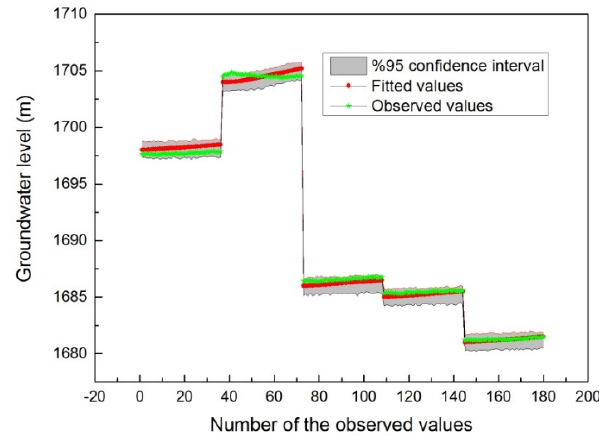
Figure 8. Fitting result of the groundwater level.